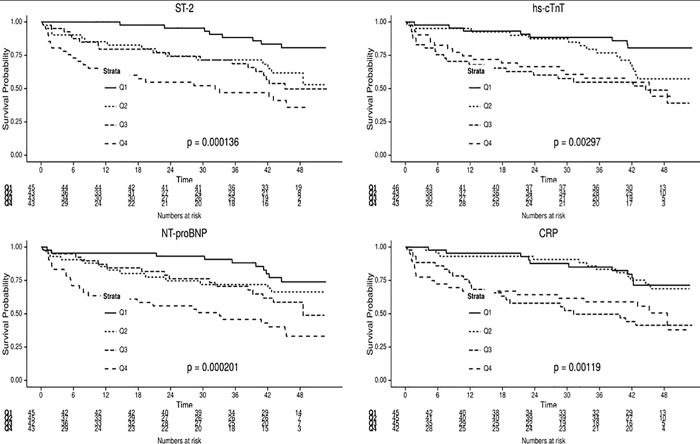
Kaplan Meier curves for all-cause mortality based on quartiles of ST2, hs-cTnT, NT-proBNP and CRP.